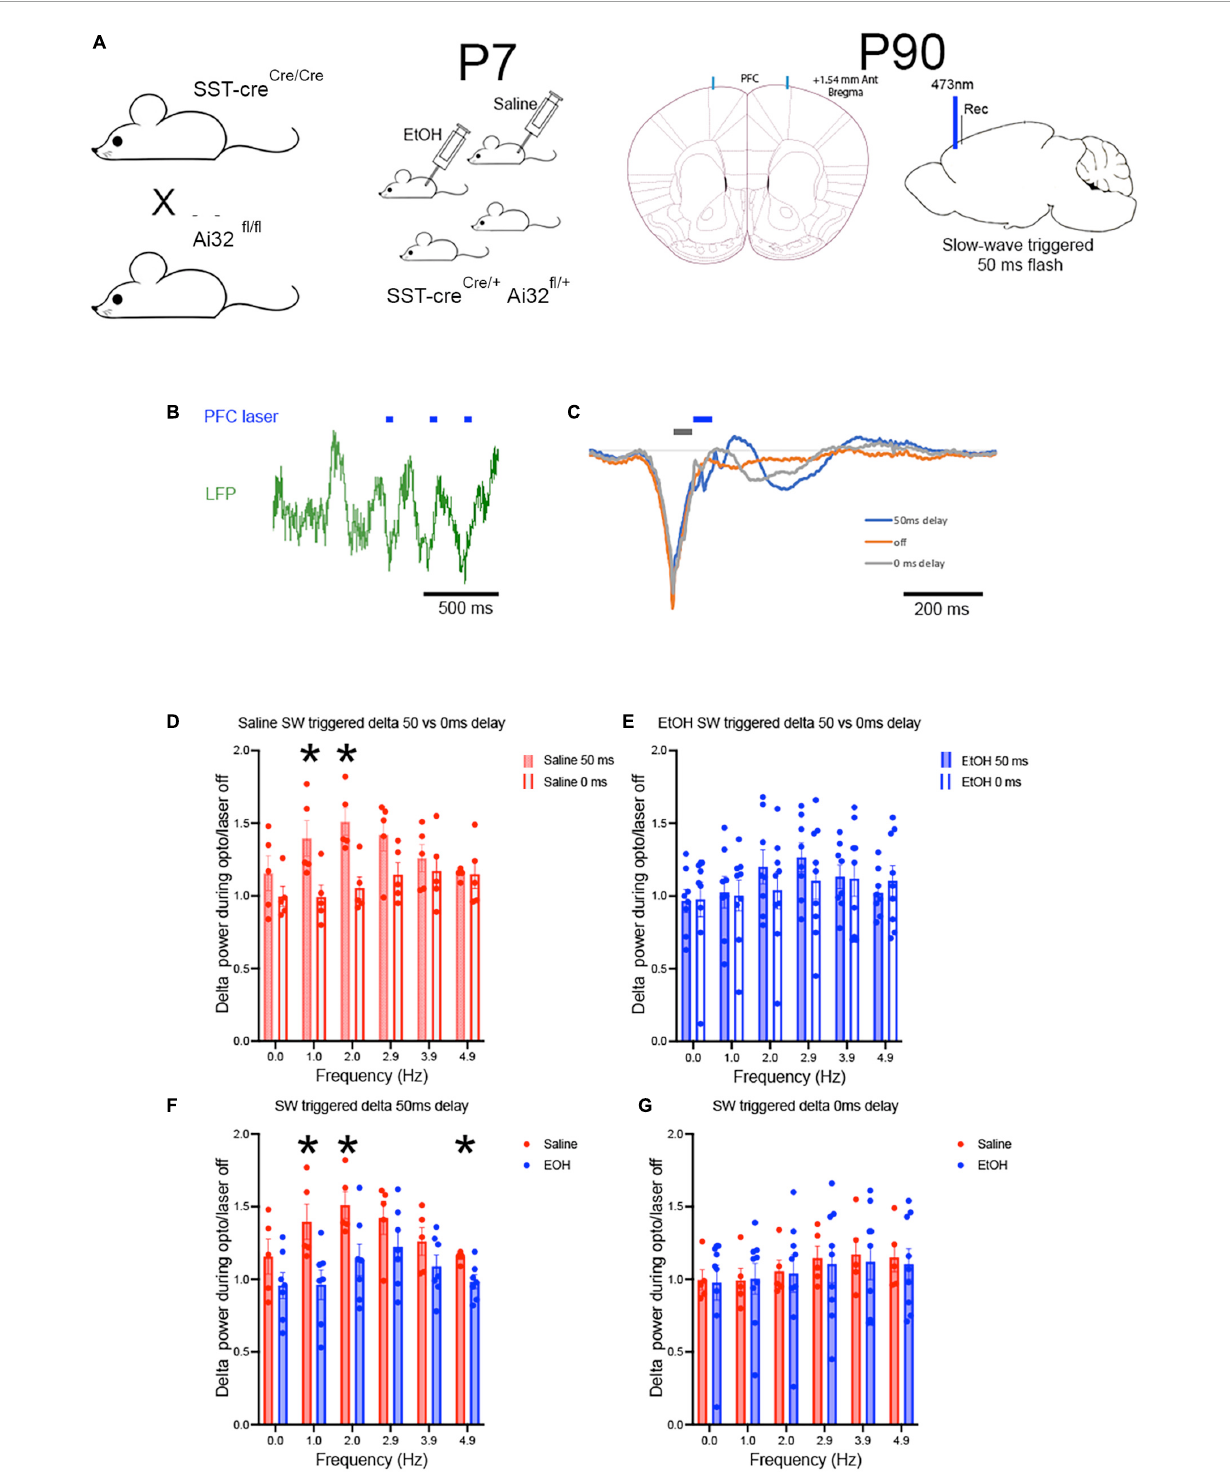
FIGURE4 Using adult SSTcreXAi32 mice exposed to EtOH ( n = 6) or saline at P7 ( n = 6) (A) , closed loop optical stimulation of cortical SST GABAergic neurons in frontal cortex (B) with 50 ms flashes triggered on spontaneously occurring slow-waves, induced sustained slow wave activity in saline but not EtOH mice. Blue marks signify timing of light flashes. (C) A 50 ms delay in light activation reinforced slow-wave activity compared to no light, while a 0 ms delay was much less effective. Gray and blue marks signify timing of light flashes starting either 0 or 50 ms, respectively, post slow-wave sleep peak. (D) Over a prolonged period (30–60 min) of such stimulation, delta band oscillation amplitude was significantly enhanced in saline controls stimulated at the 50 ms delay but not at the 0 ms delay. Asterisks = sig. diff between delays. (E) In P7 EtOH treated adult mice, neither stimulation protocol was effective at enhancing delta oscillation amplitude. (F,G) Replotting the data shows the robust enhancement of delta amplitude in saline treated mice, but not in P7 EtOH treated mice, suggesting that stimulation of spared SST cortical neurons cannot compensate to improve sleep-related slow-wave amplitude. Asterisks = significant post-hoc test differences between